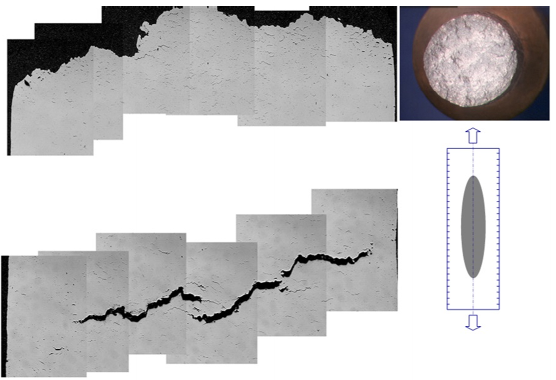
Figure 13. Creep dominated crack development in a 1CrMoV rotor steel (the upper and lower profiles